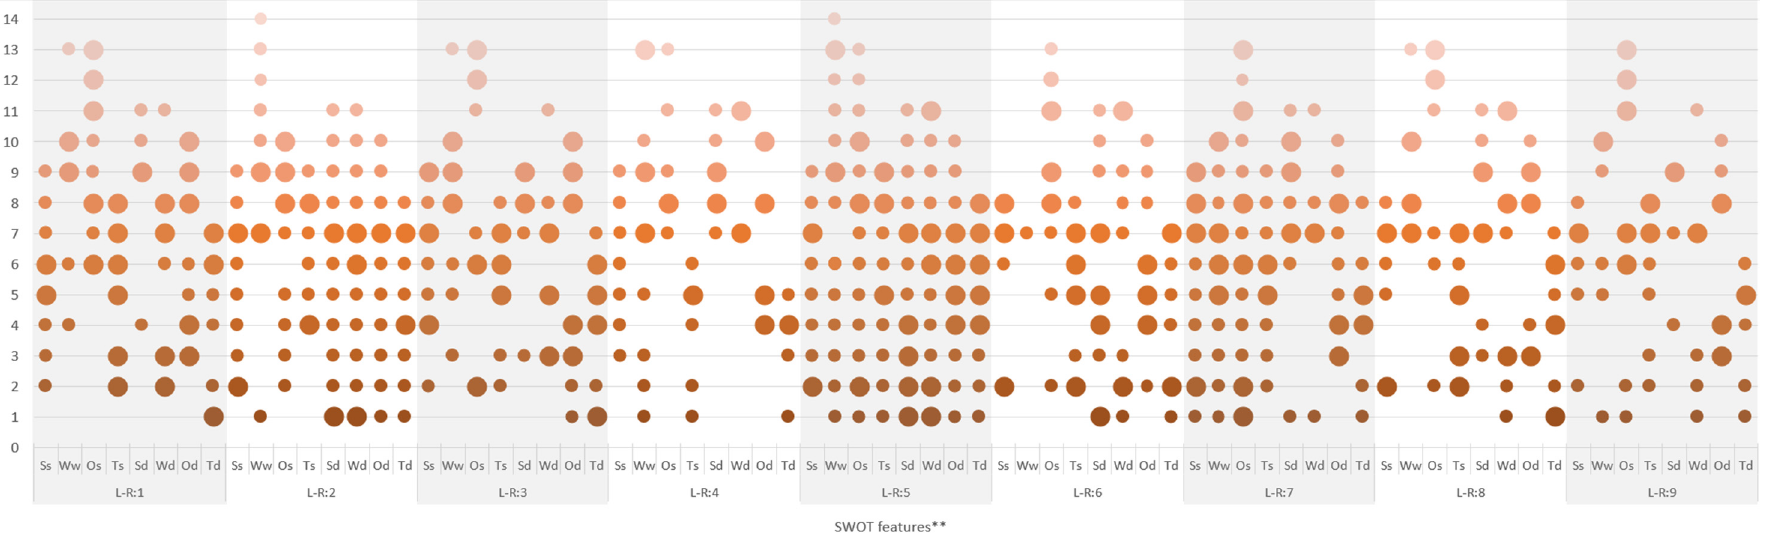
Figure A2. Clustered SWOT elements to formulate long run BSChs features to feed the Delphi questionnaire (larger circles represent the main elements while the smaller circles represent supporting elements)1. * SWOT codes correspond to the numbering of SWOT elements in Tables A1–A4, i.e., Ss-1 Inferior good at the heat market ** SWOT features correspond to the numbering of short run: immediate action BSCh features in Table 3; i.e., L-R:1. BECCSU * could replace all forms of fossil CO2Increase in pellet production due to improved forest